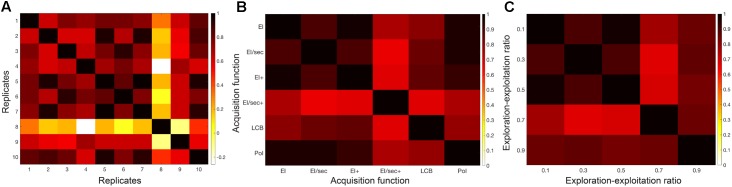
Classification model stability over varying Bayesian optimization parameters. Correlation heat maps illustrating the relationships between model objective function solutions across (A) replicates of the protocol, (B) six different acquisition functions, and (C) a range of exploration-exploitation ratios between 0.1 and 0.9 (where exploitation is 1-exploration).